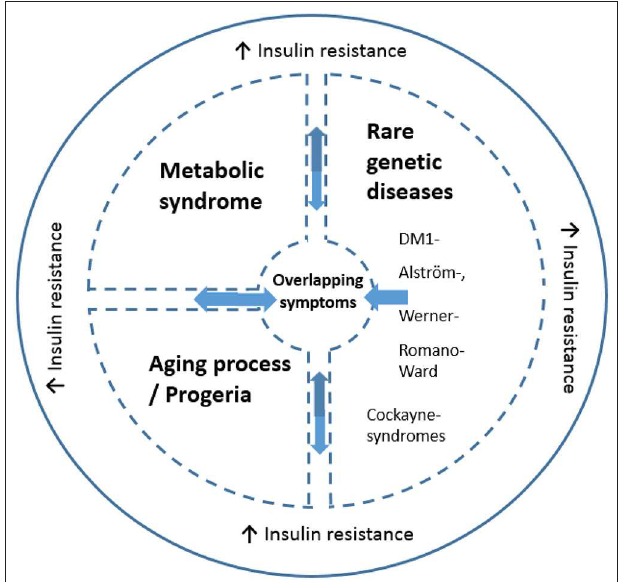
FIGURE 2 | Schematic illustration of the link between altered insulin resistance/signaling and common symptoms across disorders (including DM1). The message is that some DM1 related symptoms are found in Metabolic syndrome, progeria and the rare genetic disease, while insulin resistance is an overlapping symptom seen all diseases. The common symptoms include but are not necessarily present in all overlapping disorders: cataracts, skull hyperostosis, early hair graying/loss, impaired muscular development or wasting, cardiac arrhythmia, hypogonadism, testicular atrophy and dyslipidemia. Insulin resistance is a key feature in some but not all DM1 cases and is present in 5–17% of DM1 cases. DM1 has symptomatic (and insulin resistance) overlap with certain rare diseases, including Alström-, Werner-, Romano-Ward, Cockayne syndromes, and ataxia